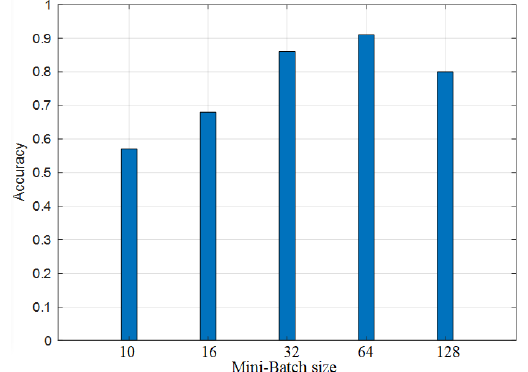
Figure 7. Accuracy versus Mini-Batch sizes.